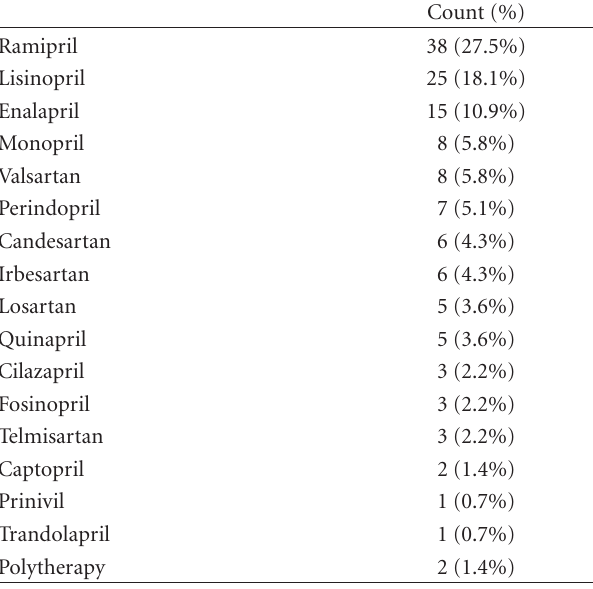
Table 2: Specific ACE/ARB’s used by expose